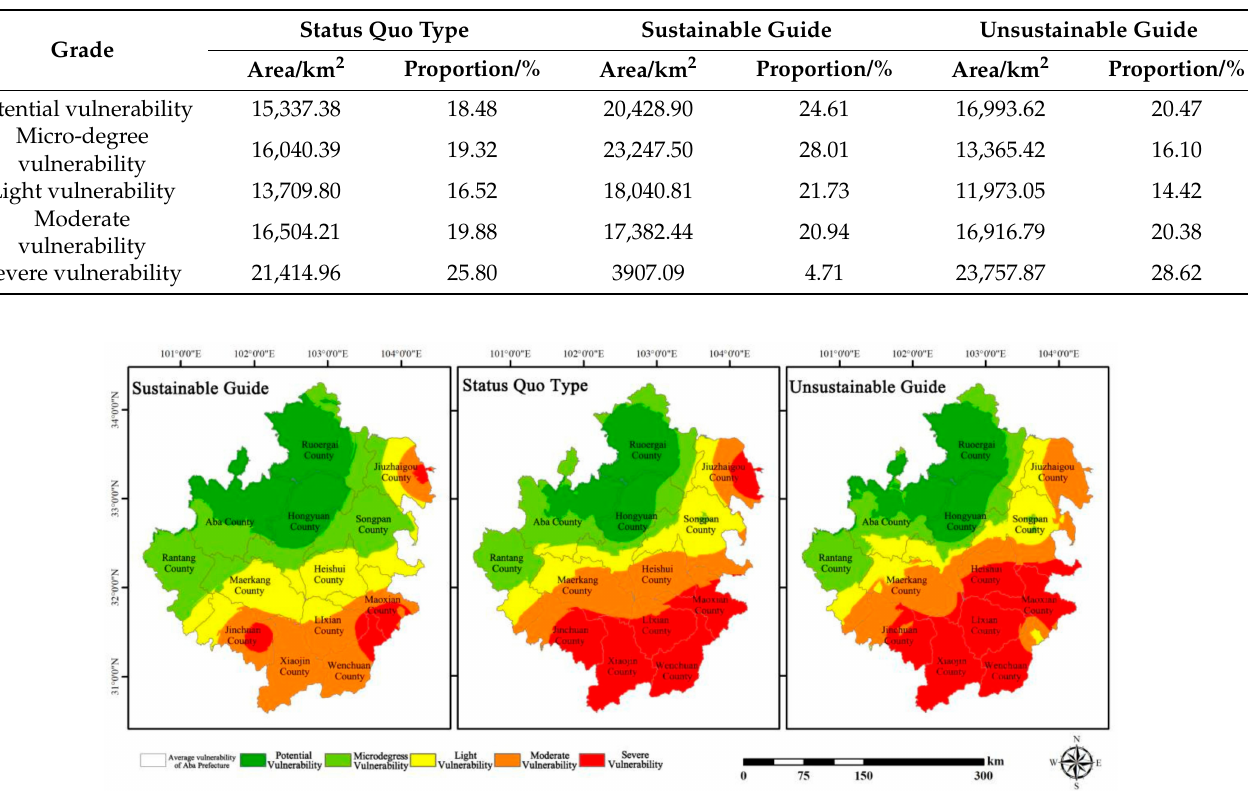
Figure 11. Spatial distribution of socio-ecological vulnerability in Aba Prefecture in different simula- tion